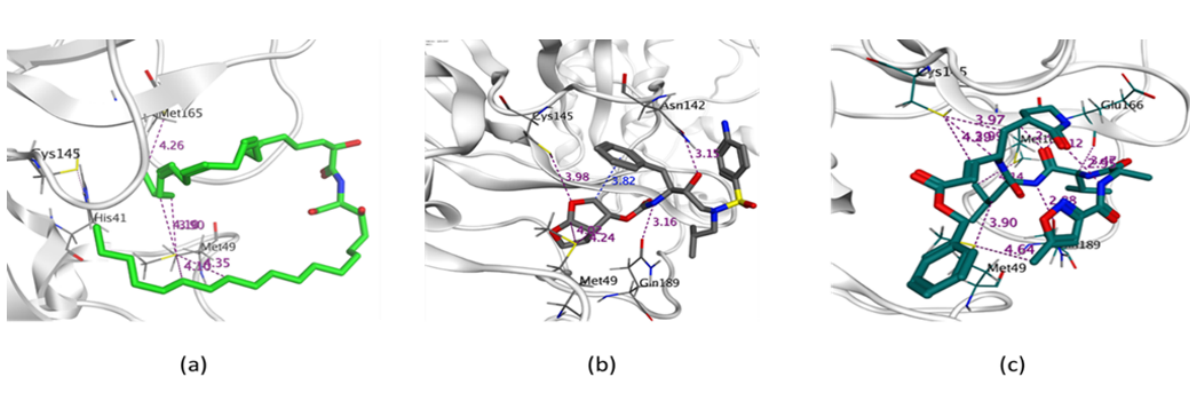
Figure 4. 2D representation of the docking of compounds Cer-4 ( a ); darunavir ( b ); and N3 ( c ) into the SARS-CoV-2 M pro .